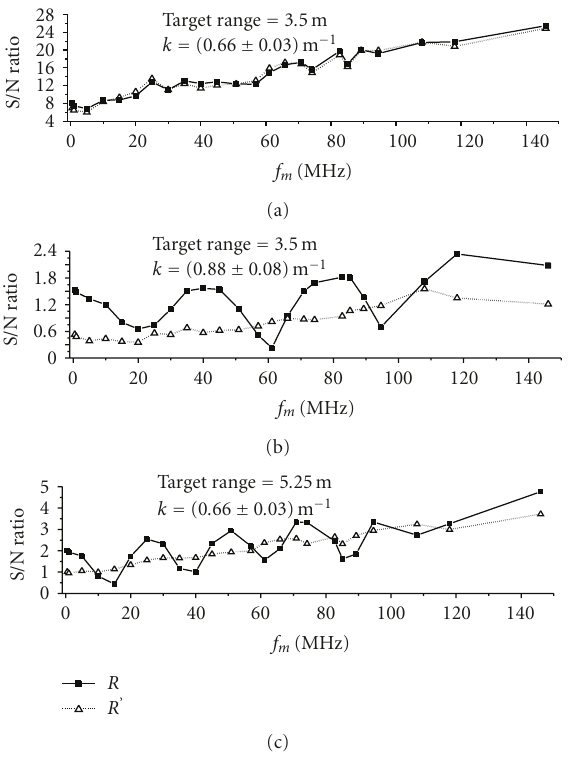
Figure 8: R and R (cid:6) versus f m for (1) z T = 3 . 5m, k = 0 . 66m − 1 , η = 0 . 08, τ = 2 . 31 (a); (2) z T = 3 . 5m, k = 0 . 88m − 1 , η = 1 . 5, τ = 3 . 08 (b); (3) z T = 5 . 25m, k = 0 . 66m − 1 , η = 0 . 6, τ = 3 . 465 (c). Note the general growing tendency of R and R (cid:6) for increasing f m .